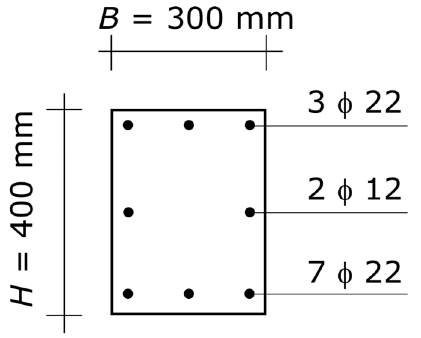
Figure 7. Optimal column of the second application example. Cross-section of the column. The diagram shows the concrete section and the longitudinal steel reinforcement, while it does not show the hoops (which shall be designed at a following stage of the structural design). The symbol φ denotes the diameter of the bars.